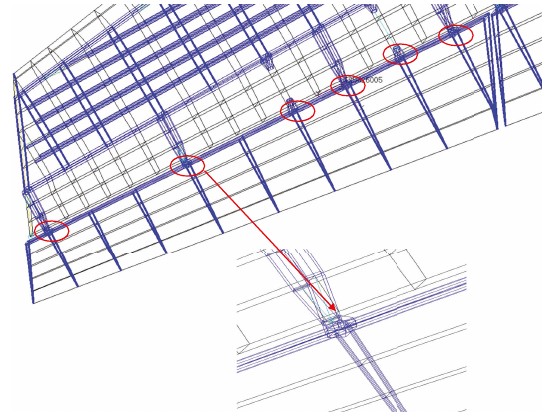
Figure 9: Six wing-aileron connectors.